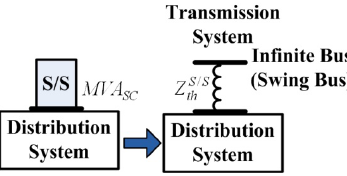
Figure 2. Including the substation bus in harmonic